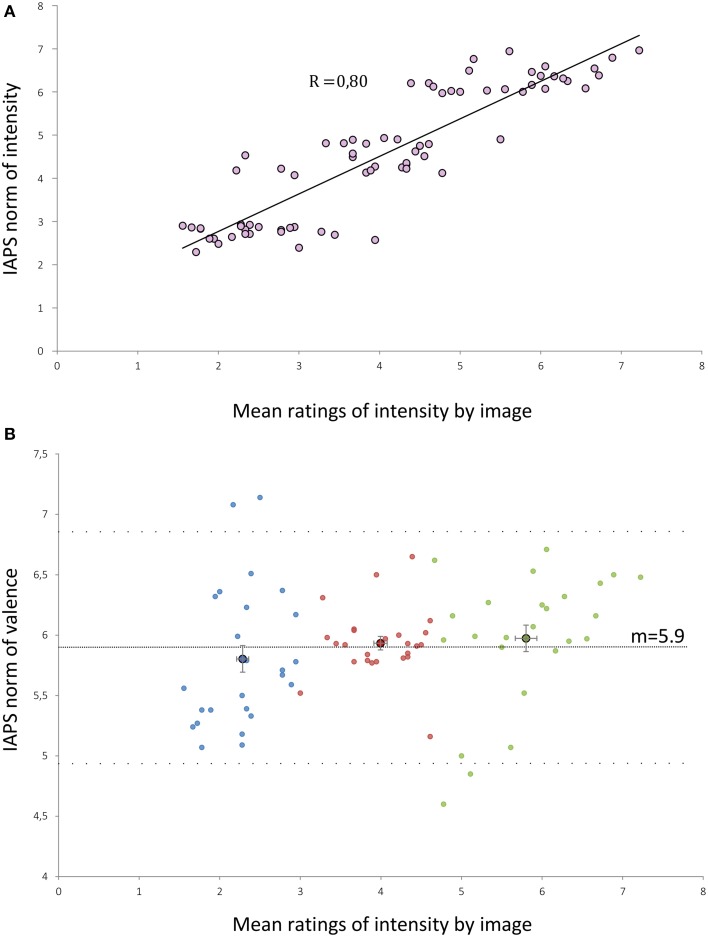
(A) Distribution of the mean intensity ratings by our subjects for each of the 75 selected IAPS pictures against the IAPS norms of intensity. R, correlation coefficient (Pearson test, p < 0.001). (B) Distribution of the mean intensity ratings by our subjects for each of the 75 selected IAPS pictures against the IAPS norms of valence. Dashed lines represent the mean valence (m = 5.9) and the mean ± 1.96 SD (4.94 and 6.87). Blue (or respectively red/green) points form the low (or respectively medium/high) intensity groups. Points with a black edge represent the means of the sub-groups. Error bars are the standard error of the mean.